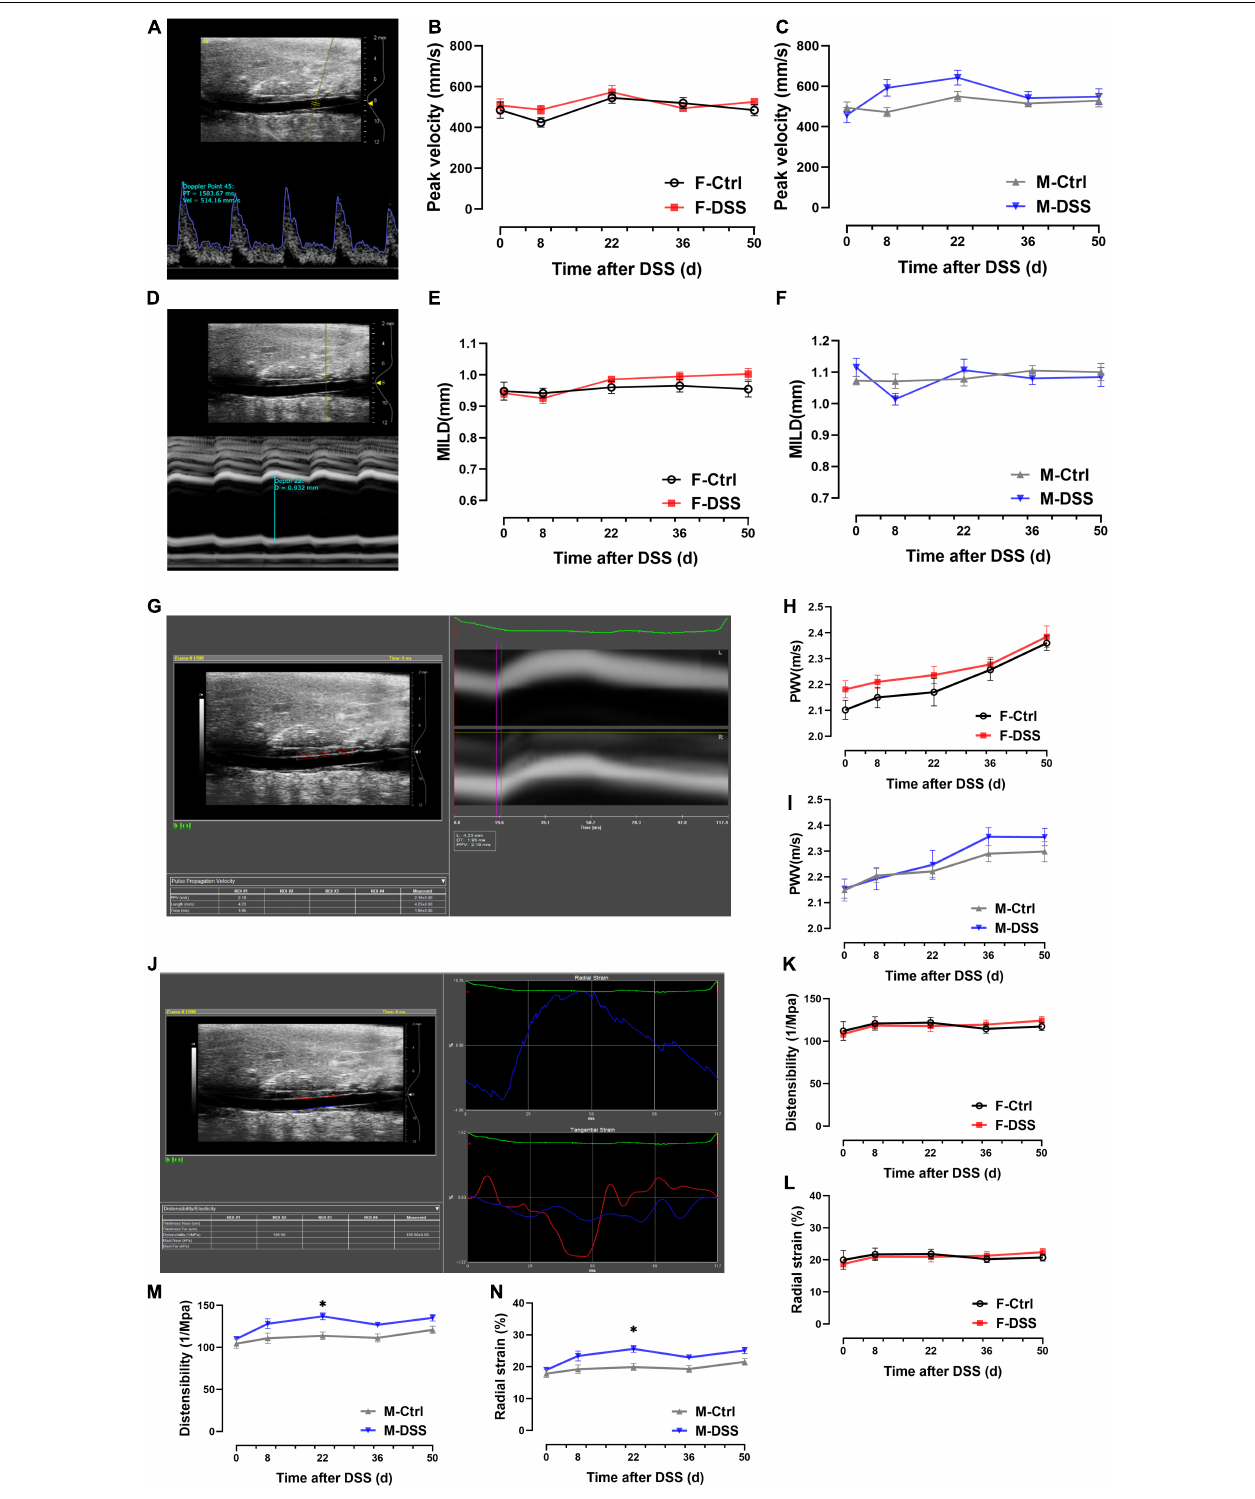
FIGURE 3 | No significant changes in hemodynamics and arterial stiffness of abdominal aorta were observed in both male and female mice with DSS-induced acute and chronic colitis. (A–C) Analysis of PW doppler mode images for peak velocity. (D–F) Analysis of M-mode images for MILD. (G–I) Analysis of EKV images for PWV. (J–N) Analysis of EKV images for distensibility and radial strain. Results are expressed as mean ± SEM. ∗ p < 0.05, in two-way ANOVA followed by Bonferroni correction (E–N) , n = 6–8 mice each group. F and M, female and male mice, respectively. MILD, maximal intraluminal diameter; PWV, pulse wave velocity.